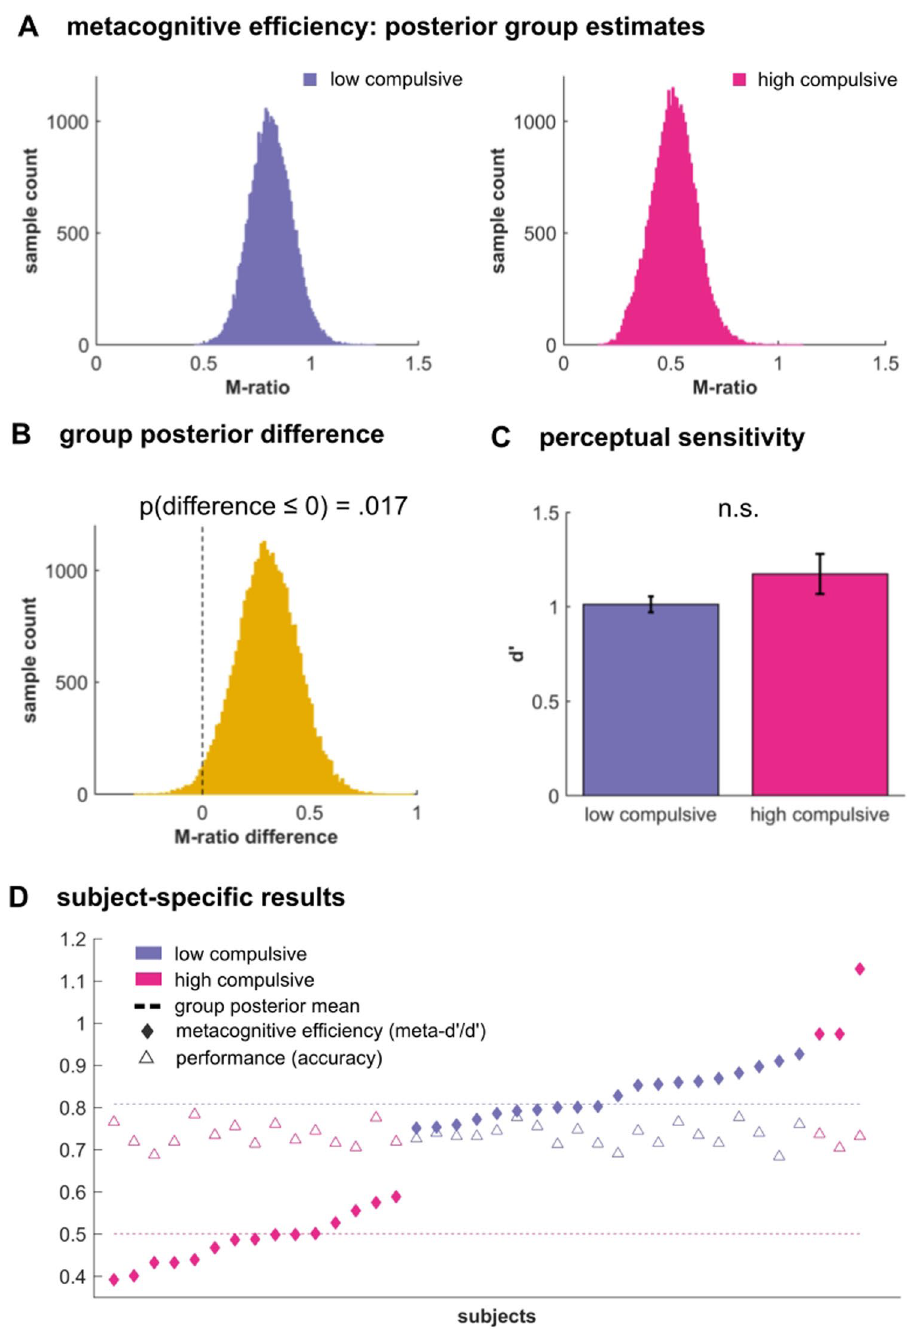
Figure 2. Metacognitive impairments in high compulsives. ( A ) Group posterior of metacognitive efficiency ( M-ratio ) for high and low compulsive participants revealed that high compulsive participants are significantly worse in their metacognitive abilities ( B ). This is not due to perceptual differences, because we controlled for performance, also indicated by the absence of a difference in the perceptual performance ( d’ , C ). ( D ) An illustration of the individual metacognitive efficiencies (diamonds) reveals that all but three participants from the high compulsive group perform worse than the low compulsives. There were no systematic biases in the accuracy (triangles) across the groups which highlights that metacognitive biases are not driven by perceptual difficulty. However, it must be noted that the metacognitive efficiencies depicted here are derived from a hierarchical model, and can thus not easily be interpreted or compared individually (i.e., they are not statistically independent). Bar plots: mean ± s.e.m.; n.s. p >